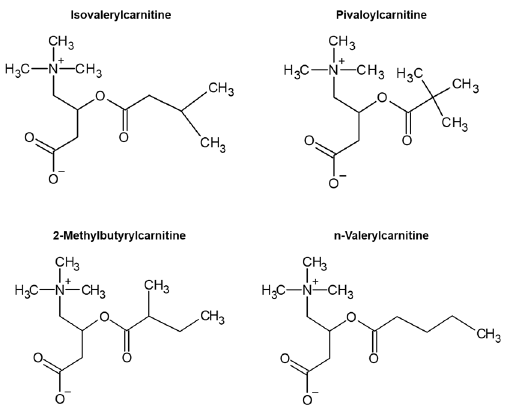
Figure 1. Structure of C5-acylcarnitine isomers.